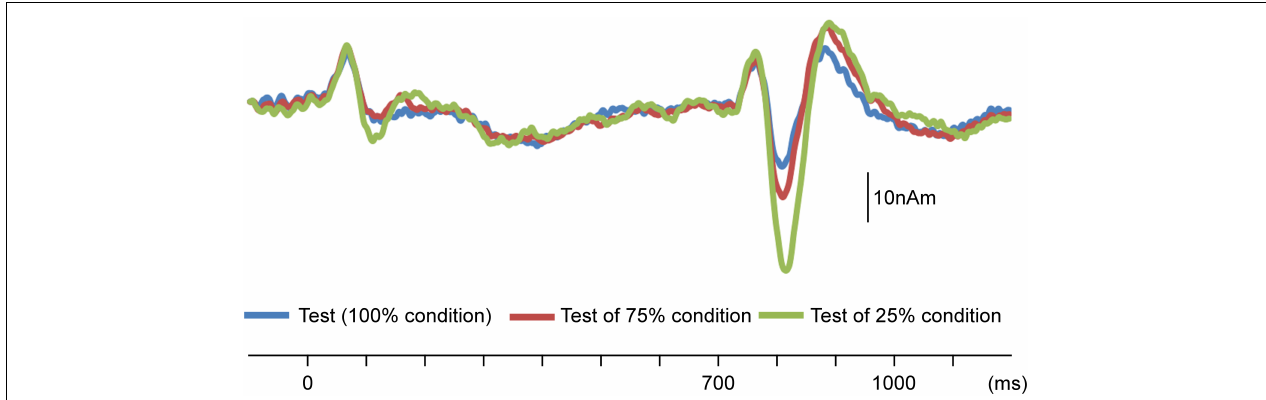
FIGURE 2 | Effects of probability on change-related cortical responses. Grand-averaged waveforms of auditory-evoked magnetic fields (AEFs) following the test stimulus across 13 participants are shown. Probability refers to that for the test stimulus.